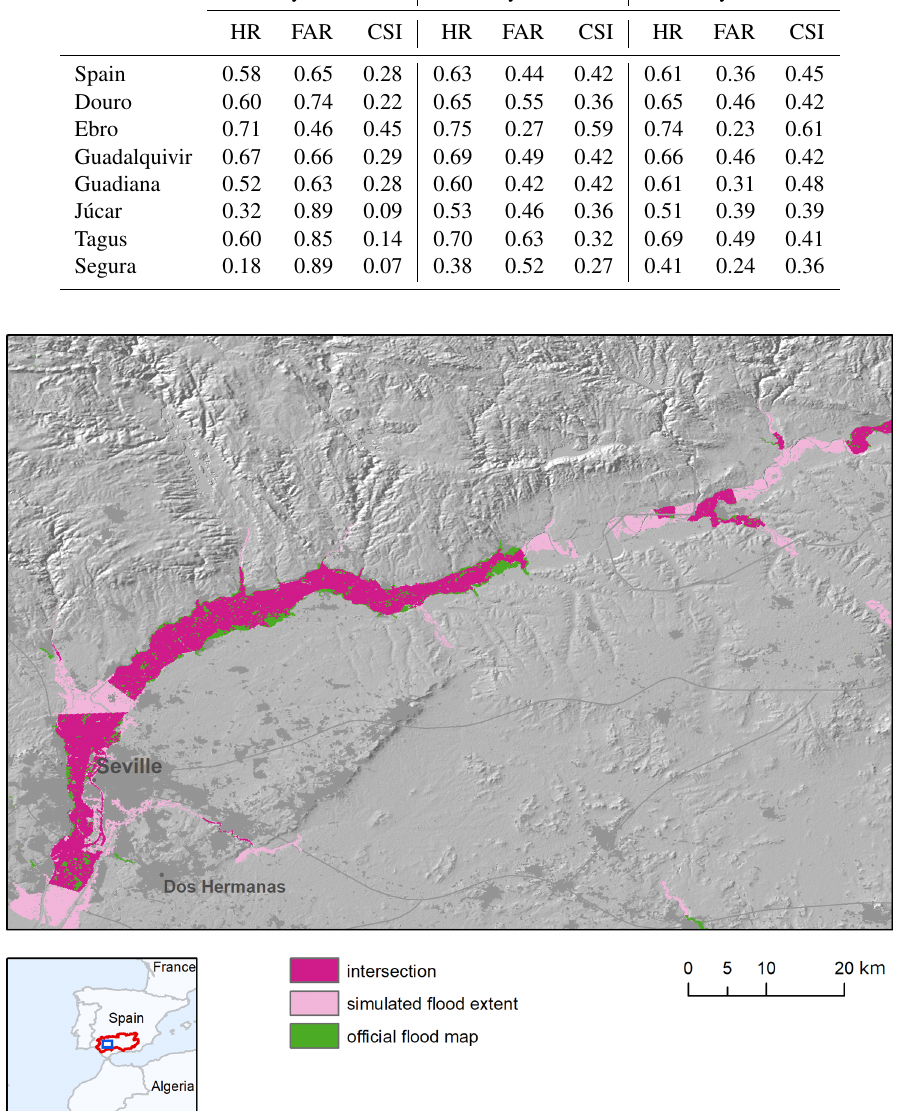
Figure 6. Comparison of modelled (blue) and reference (green) flood hazard maps (1-in-100-year flood hazard) over a stretch of the Guadalquivir river basin, Spain. Purple areas denote the intersection between the two sets of maps.